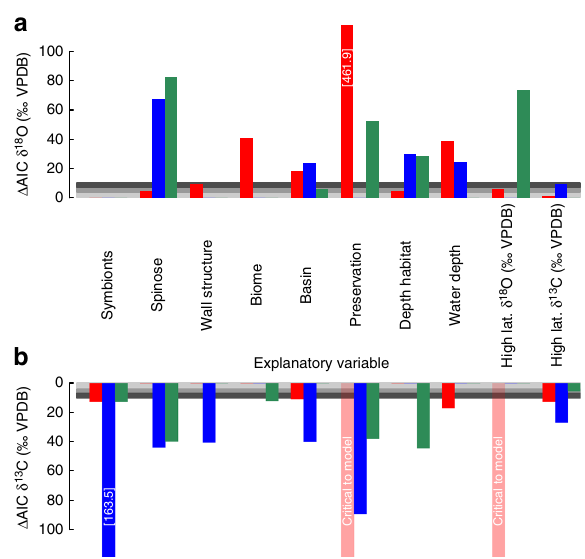
Fig. 2 Testing the controls on size-speci fi c stable isotope values. Each colored set of bars represents the contribution of each of the environmental, biological and preservational variables to the intercept (red), linear slope (blue) or non-linear slope (green) of the model fi tted to the raw δ 18 O ( a ) or δ 13 C ( b ) data. The height of each bar is the difference in the Akaike Information Criterion ( Δ AIC) between MAM outputs with and without the listed focal variable, an indication of the explanatory power of each variable. Horizontal grey bars follow the criteria of ref. 65 . The light grey zone ( Δ AIC < 4) indicates similar model outputs with and without the focal variable, i.e., low explanatory power of variable. The grey bar ( Δ AIC 4 – 7), dark grey bar ( Δ AIC 7 – 10) and the white region above ( Δ AIC > 10) indicate increasingly divergent amounts of support between model outputs, and thus the focal variable explains substantial variation. Translucent red bars marked ‘ critical to model ’ indicates that the model fails to converge on a solution if it is removed